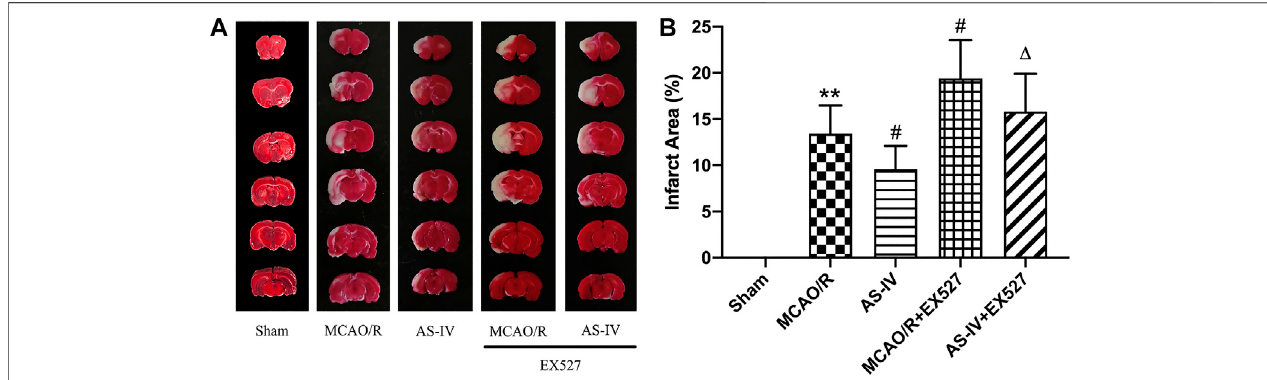
FIGURE 7 | The cerebral infarction areas in Sham, MCAO/R, AS-IV, MCAO/R + EX527, and AS-IV + EX527 group at 7 days after CIR injury in rats (mean ± SD, n (cid:1) 6). (A) TTC staining. (B) Quantitative analysis for the percentage of the infarction area. ** p < 0.01, compared with the Sham group; # p < 0.05, compared with the MCAO/R group; Δ p < 0.05 compared with the AS-IV